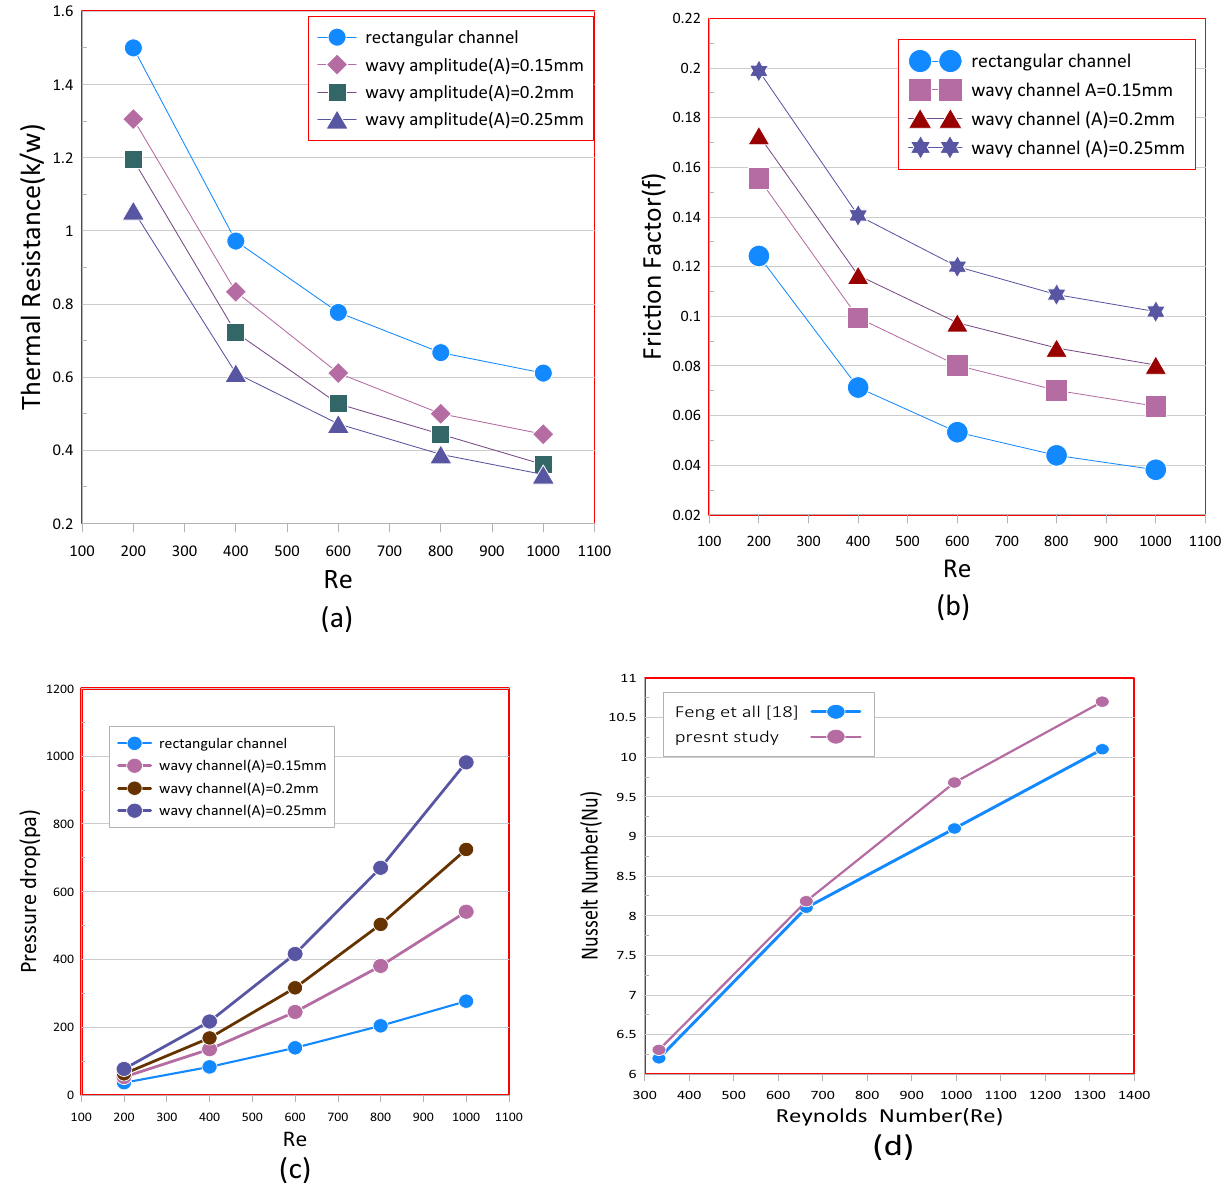
Figure 11. Relation between ( a ) thermal resistance (R th ) ( b ) friction factor (f) ( c ) pressure drop and ( d ) Nusselt versus Reynolds number (Re) in rectangular channel and wavy factor (f) increase with the increases in wave amplitude as a result of the high pressure reduction persuaded by increase the flow objection with a wavy path. From Fig. 11c, the relationship between a pressure drop and Reynolds number (Re) can also be found to be proportional. With an increase in the Reynolds number (Re), a pressure drop also increases. It is clear that the corrugate channel has a greater pressure drop than a conventional channel. with high wave amplitude, the more the pressure drops accure because of flux disruptions due to variations in the orientation of the channel and secondary flow in a wavy channel created and the contacts between a vortices and the walls of the channel often increase heat sink pressure losses. Figure 11d shows the Nusselt number ratio of rectangular mini channel and wavy channel for various cases. The heat transfer in any wavy channel relative to a rectangular channel can be expected to be increased. Regard- less of a channel configuration, the (Nusselt number) rises with increasing the Reynold number at a cost of higher pumping power Pp. With the Reynolds rise, a thermal boundary layers in the channels decreases with the temperature gradient increasing near to channel walls, thereby contributing to higher heat transfer. Fluid flow through waves is subject to a centrifugallforce which disrupts a flow field and which can result in a recir- culation of fluids 27 .